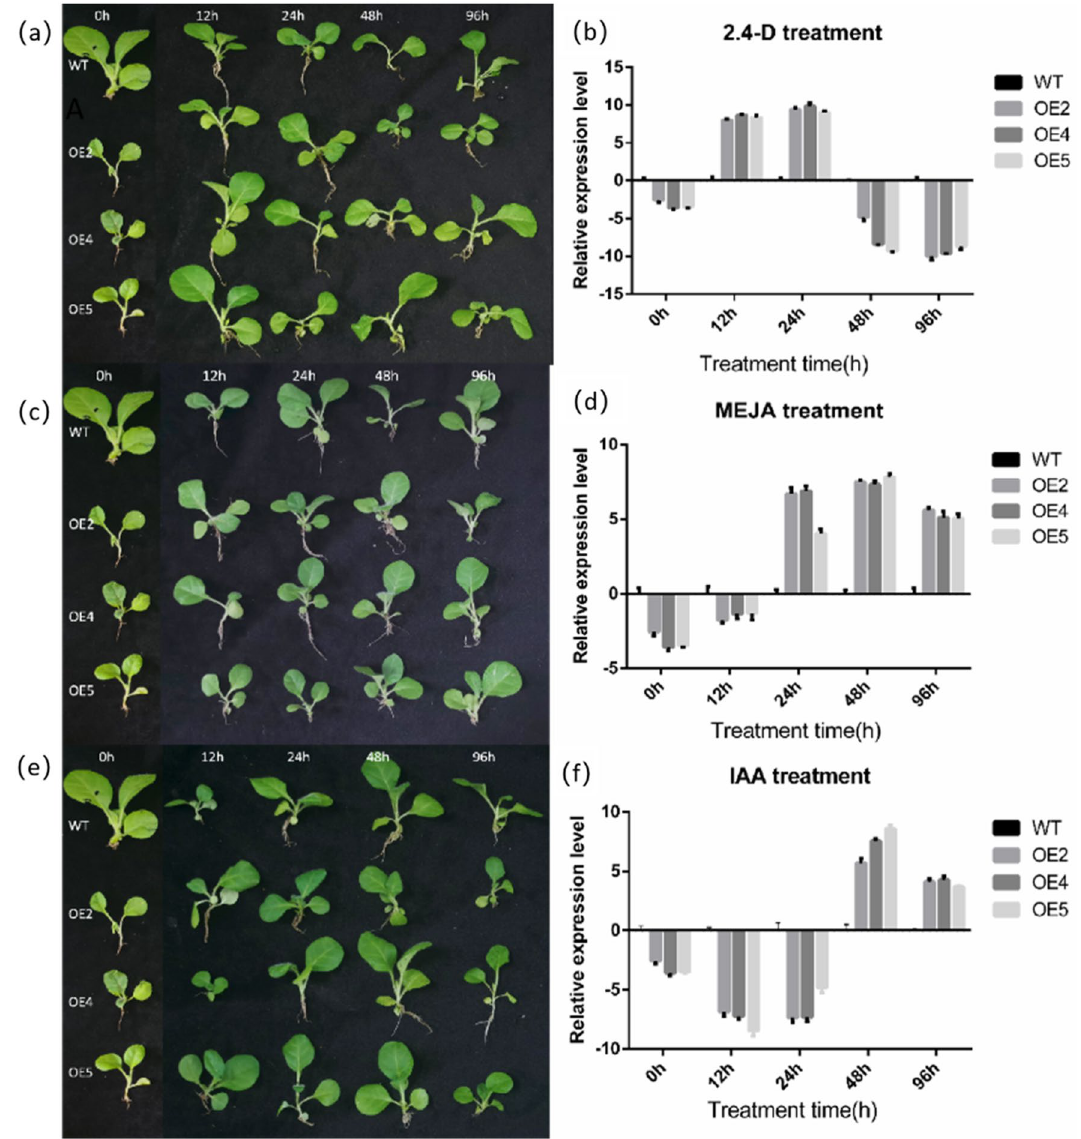
Figure 13. Relative expression levels of transgenic and wild-type tobacco under different hormone treatments. ( a ), ( b ) Tobacco treated with 2,4-D hormone; ( c ) ,( d ) Tobacco treated with MeJA hormone; ( e ), ( f ) Tobacco treated with IAA hormone; WT wild tobacco, OE2-OE5 different transgenic